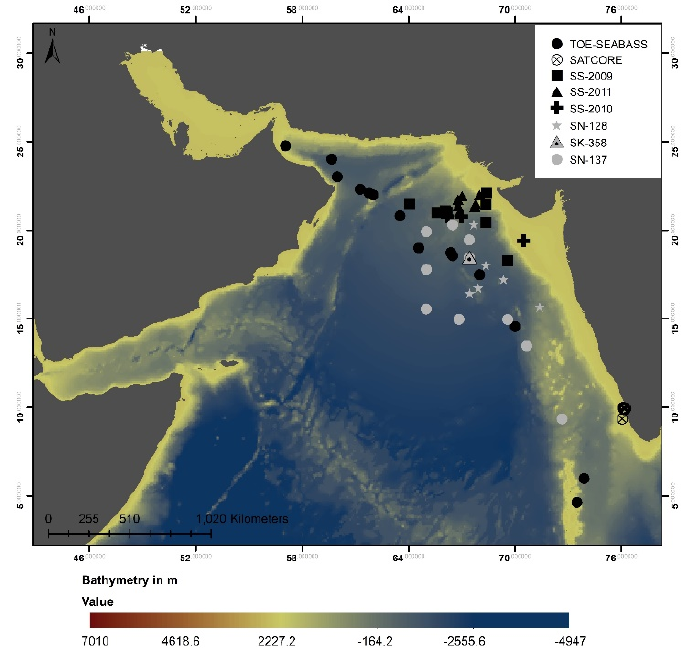
Figure 1. Map displaying the bathymetry of the Arabian Sea and the locations of the cruise sampling stations. Markers in grey represent the database obtained from field observations. Markers in black represent the database obtained from various sources.